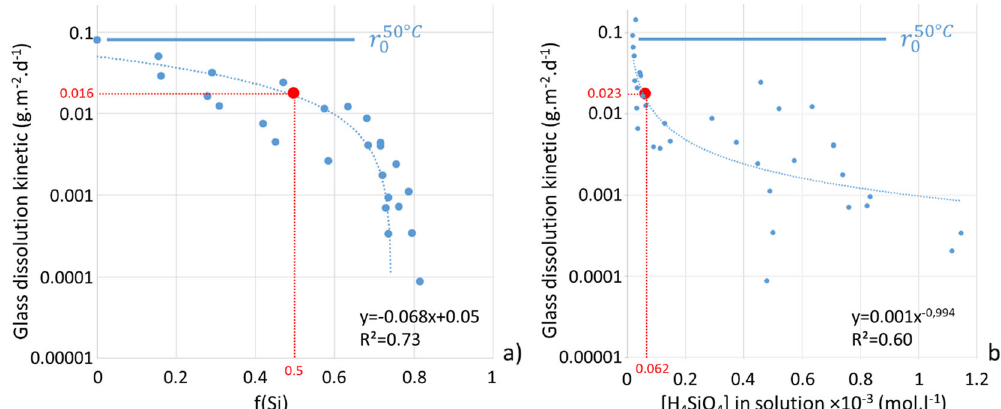
Fig. 8 Estimated glass dissolution kinetics in function of silicon retention (f(Si)) or H 4 SiO 4 concentration in solution. According to the f(Si) = 0.5 in GAL and the [H 4 SiO 4 ] = 0.062 mol l − 1 in solution, the glass alteration rates associated with these values are respectively 1.6 × 10 − 2